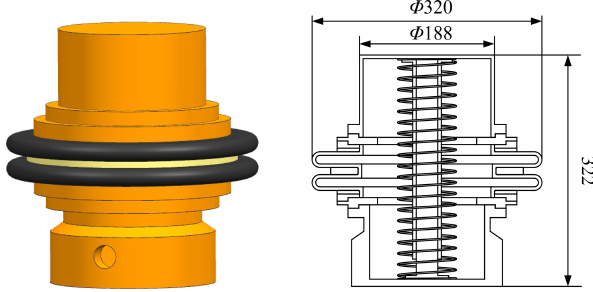
Figure 3. Dimensions of a rubber bellows type pressure compen- sator.